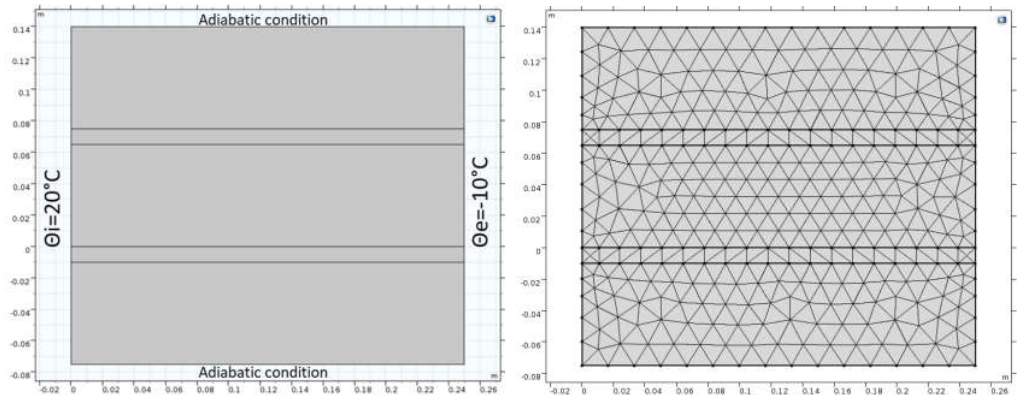
Figure 2. Adiabatic conditions and boundary settings of the models under the steady-state condition.